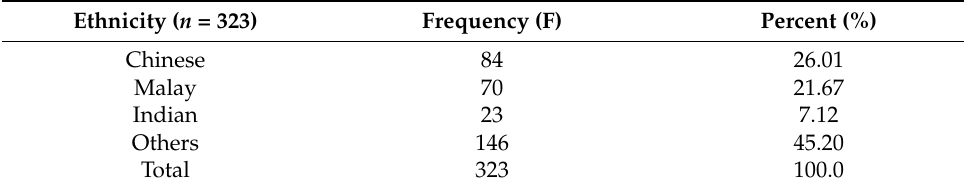
Table 2. Frequency and percentage of respondent